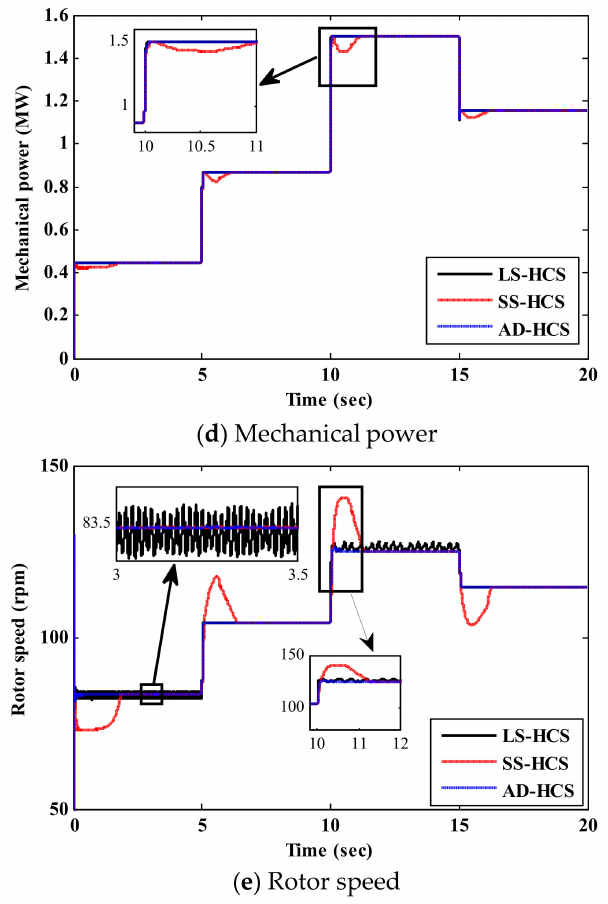
Figure 9. Simulation results under step-change wind speed.